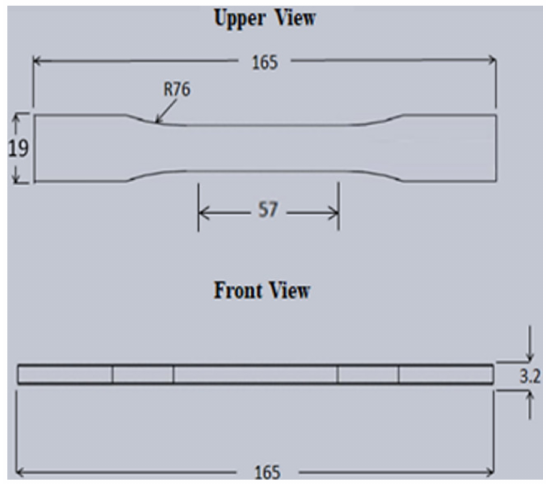
Figure 2. Dimensions of the specimen in